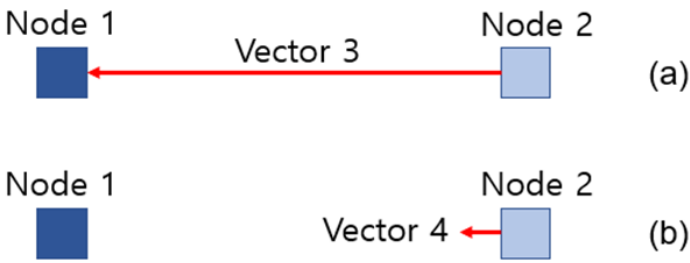
Figure 6. Result of vector normalisation: ( a ) result of vector subtraction between Node 1 and Node 2; and ( b ) result of Vector 3 normalisation.